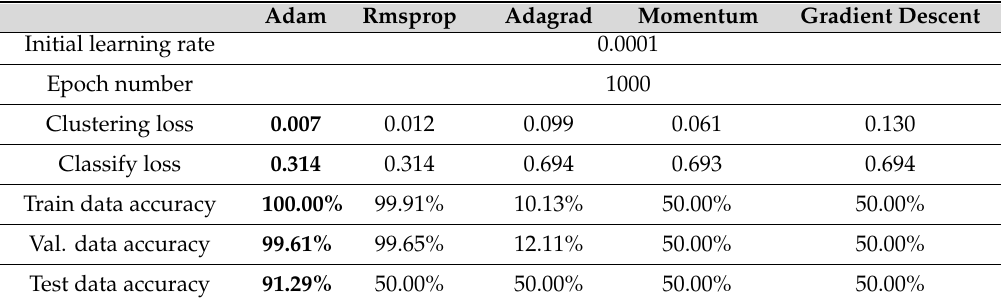
Table 2. The comparison results of popular algorithms.